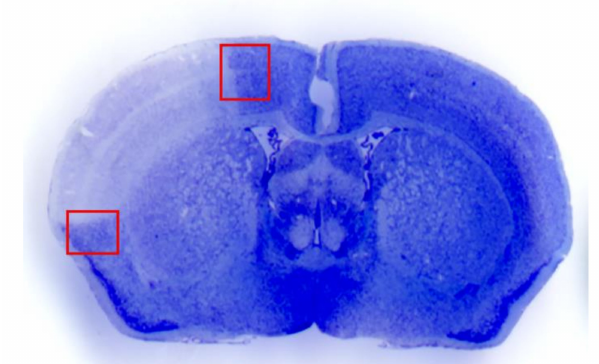
Figure 2. Representative picture of dissected regions. Selective brain regions of dissected area penumbra are shows in representative